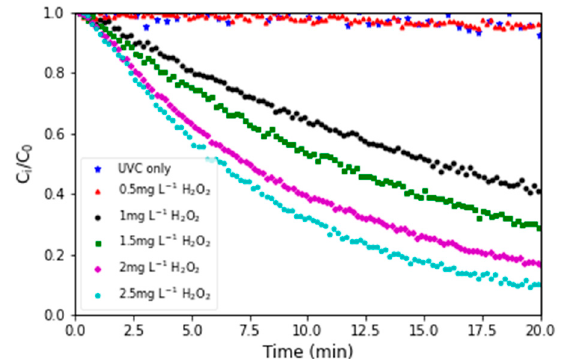
Figure 5. Photodegradation of 21.2 μ M (5 mg L − 1 ) carbamazepine solution under UVC irradiation at several concentrations of hydrogen peroxide. Table 3. Pseudo-orders and half-life times for photodegradation experiments. Heterogeneous